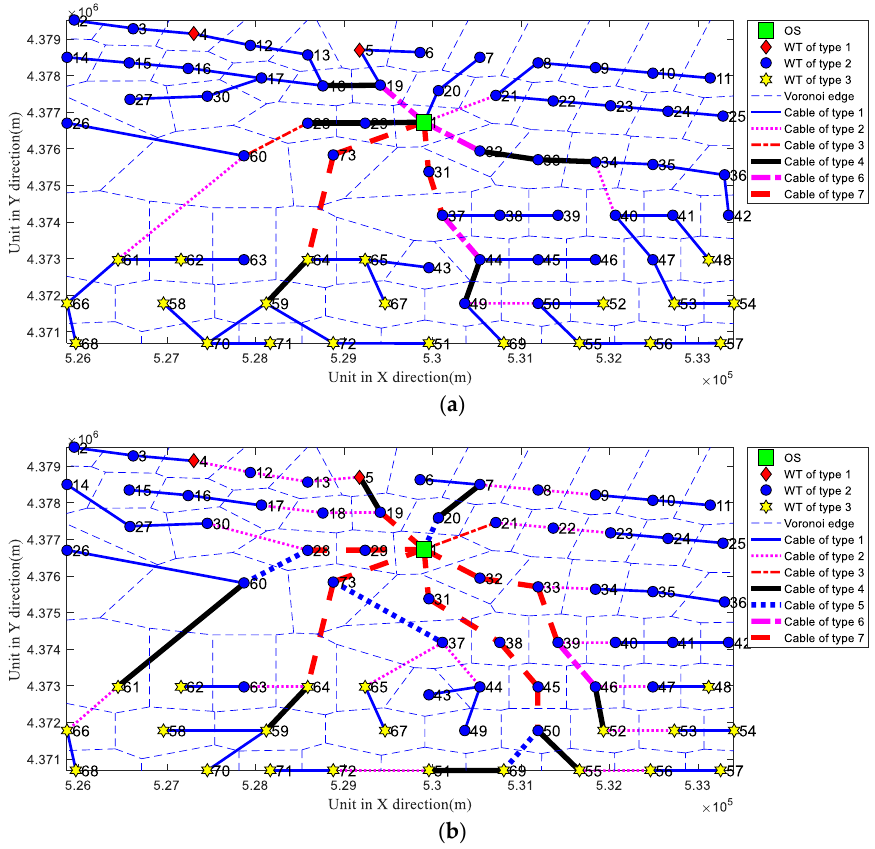
Figure 9. Optimized cable connection scheme. ( a ) Optimized layout of Model 1 obtained by V-APSO-LS; ( b ) Optimized layout of Model 2 obtained by V-APSO-LS.